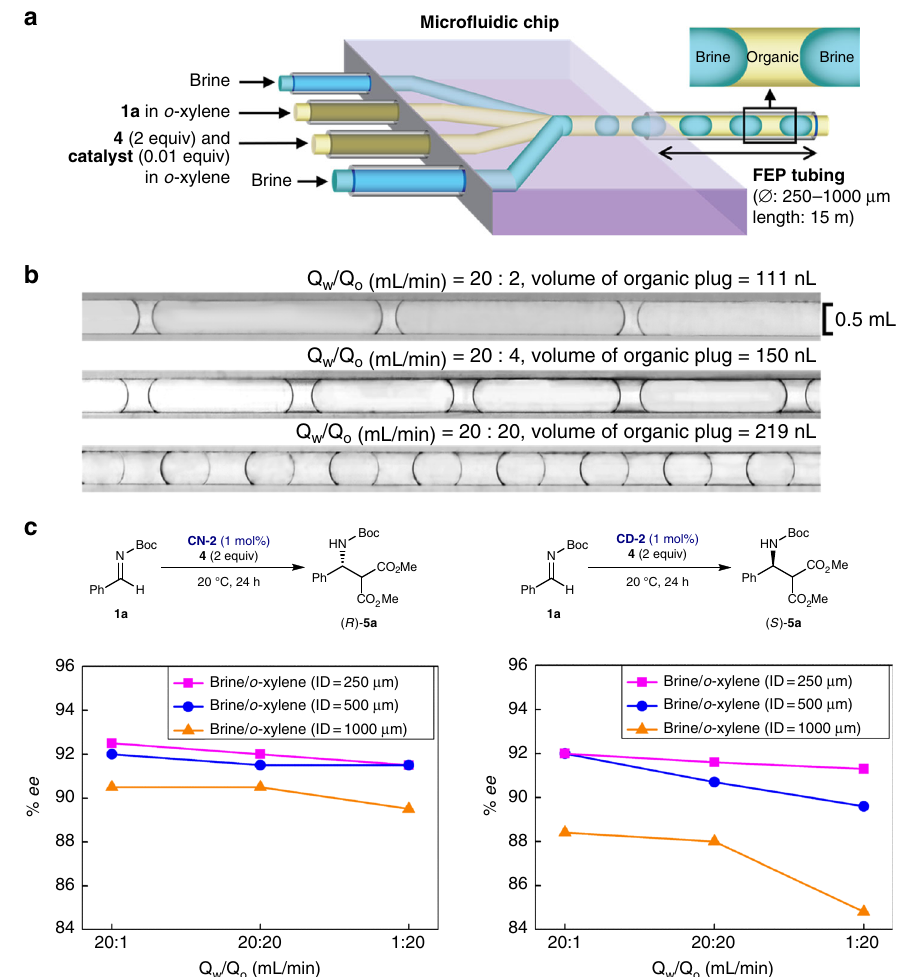
Fig. 3 Micro fl uidic experiments. a Flow microreactor system for the Mannich reaction of 1a with 4 using 1 mol% of CN-2 or CD-2 : plugs form at the junction between a o -xylene solution containing the reagents (organic phase) and an aqueous phase (brine), and travel down the FEP ( fl uorinated ethylene propylene) tubing where the reaction occurs. b Plug volume can be controlled by varying the relative fl ow rates of the two phases (Q w : aqueous fl ow rate, Q o : organic fl ow rate). *Plug volume was determined by dividing the organic fl ow rate (Q o ) by the droplet production frequency, measured using a high speed camera. c Effect of biphasic micro fl uidic conditions (i.e., droplet size) on